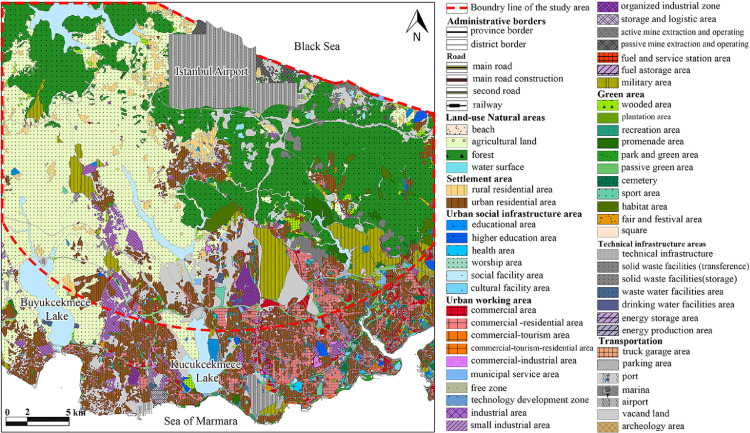
Land use planning map of the study area [7].